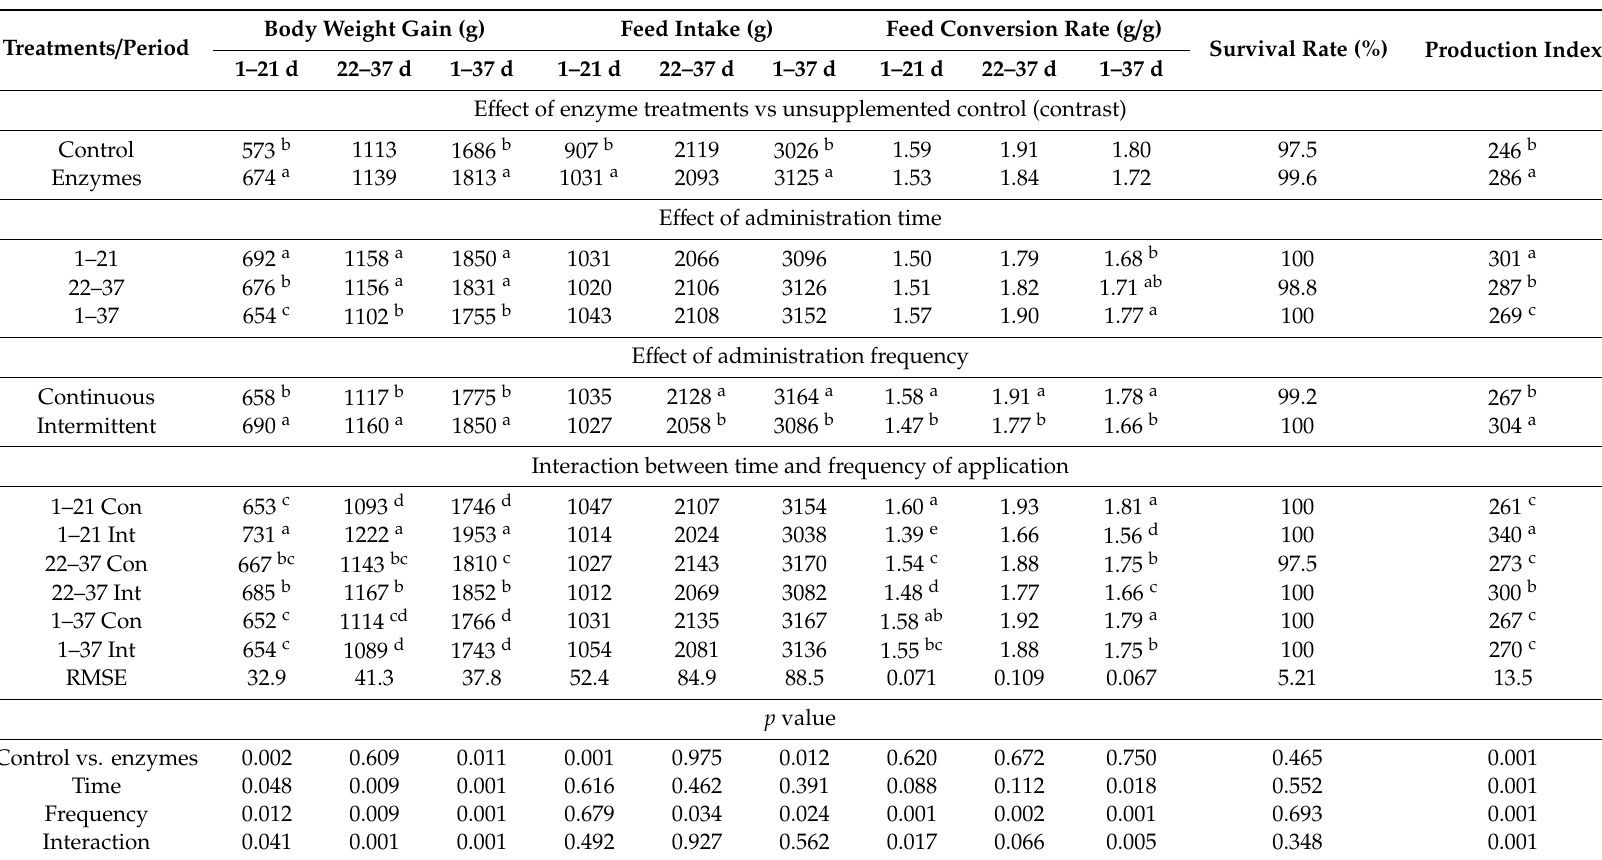
Table 2. E ff ect of multienzymes supplemented in water continuously or intermittently during the starter, grower, and the whole time on growth performance of broiler